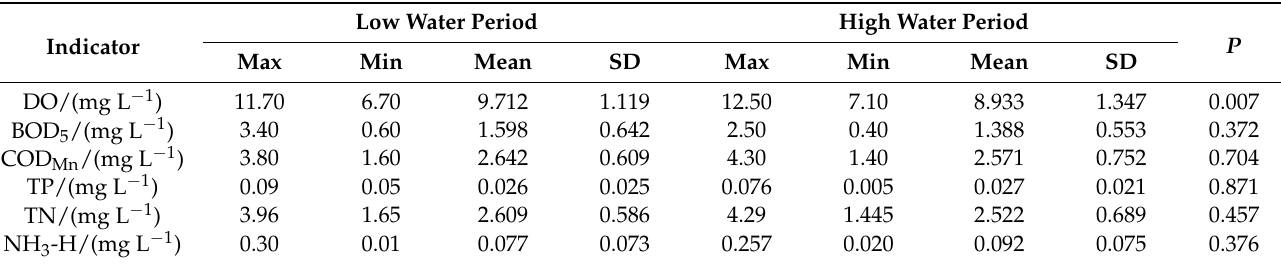
Table 4. Statistical description of the Gulou section.